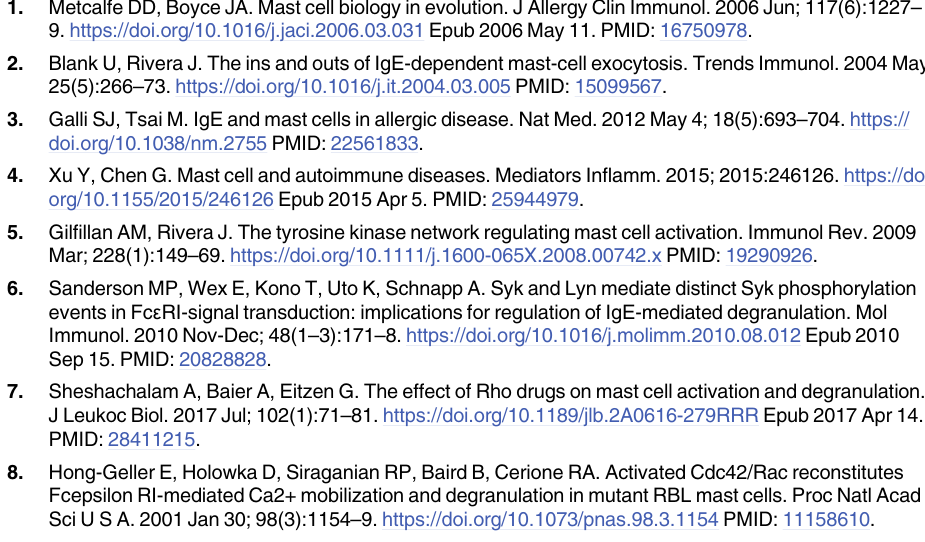
S1 File. Raw data for results presented in figures and Table 2. See the figure legend for